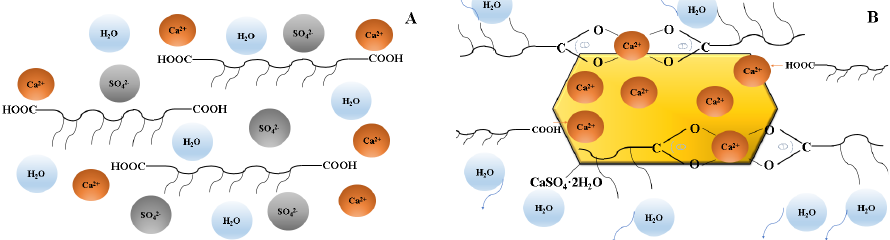
Figure 7. Schematic illustration of coordination between Ca 2+ and –COO − groups. ( A ) PCEs dissolved in β− HH; ( B ) PCEs adsorbed on the surface of β− HH particles.